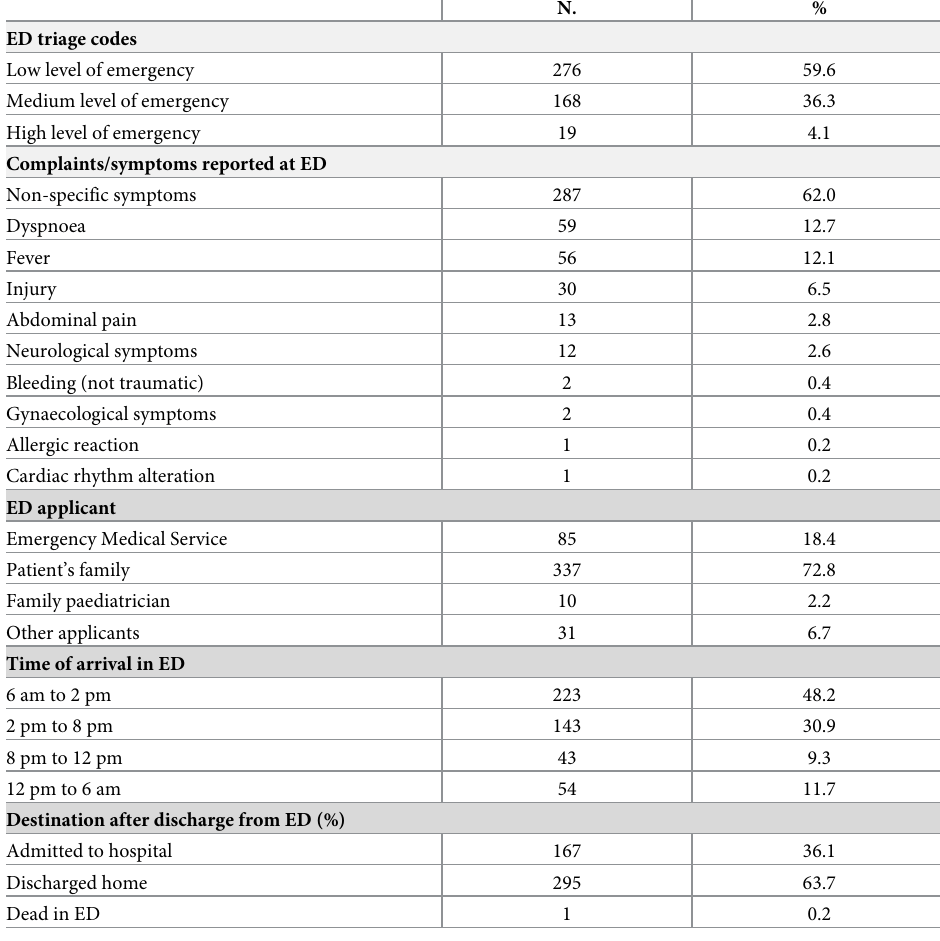
Table 2. Main characteristics at ED arrival and discharge (n = 463 events) among patients enrolled in the IPHC program between 2012 and 2017.